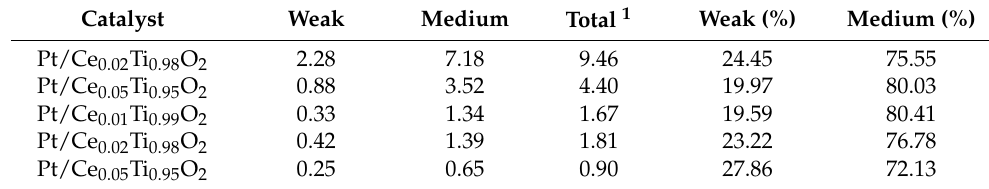
Figure 9. NH 3 -TPD profiles of Pt/Ce x Ti 1 − x O 2 (x = 0.002, 0.005, 0.01, 0.02, and 0.05) catalysts. (A: weak acid and B: medium acid). Table 3. NH 3 -TPD results of Pt/Ce x Ti 1 − x O 2 (x = 0.002, 0.005, 0.01, 0.02, and 0.05) catalysts.